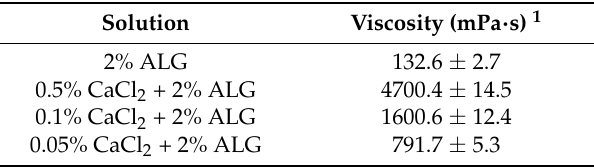
Table 2. Viscosity of CaCl 2 cross-linked ALG